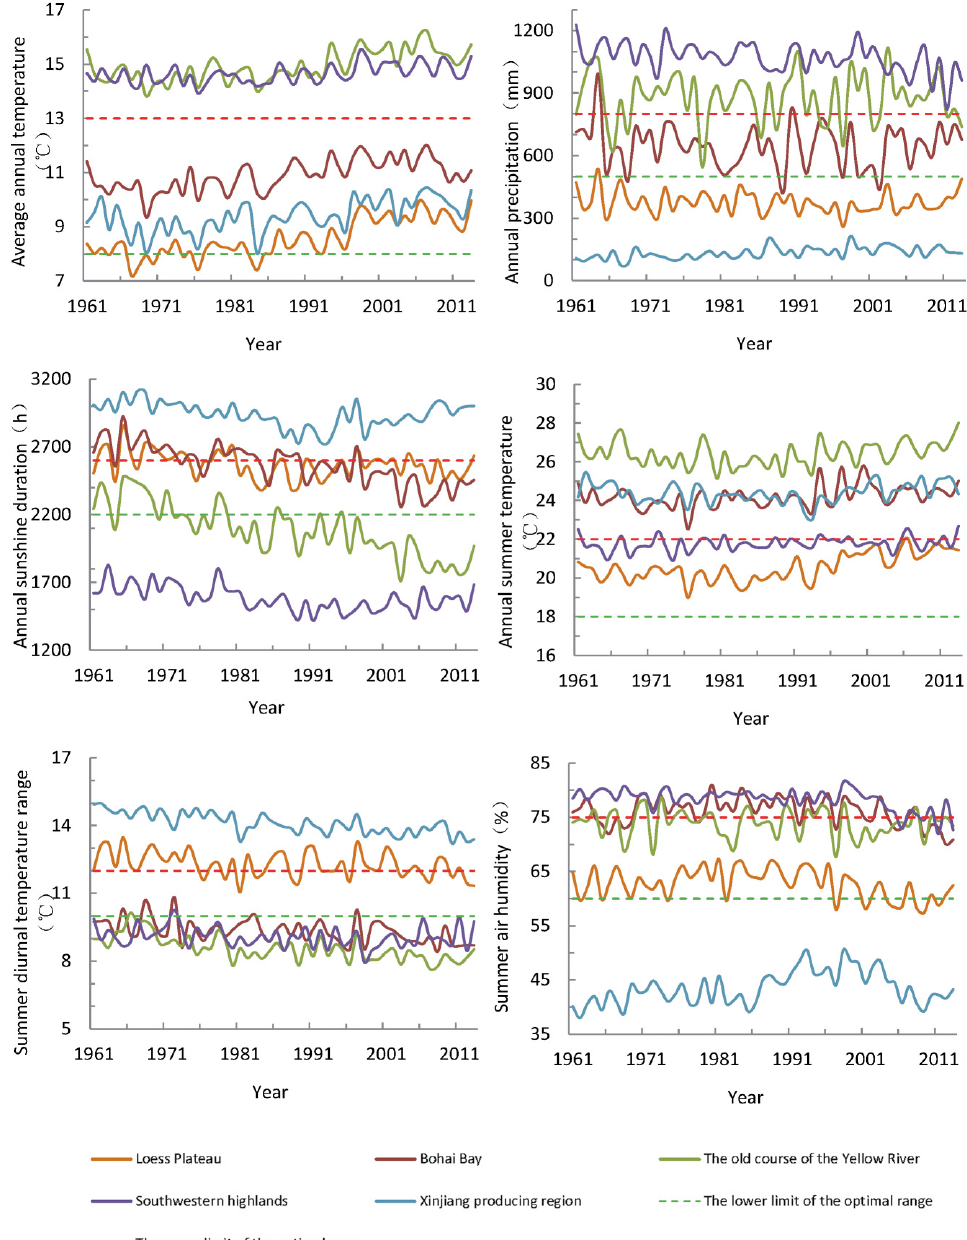
Figure 3. Annual variations of the major climate factors affecting apple quality in the different apple-producing regions of China.